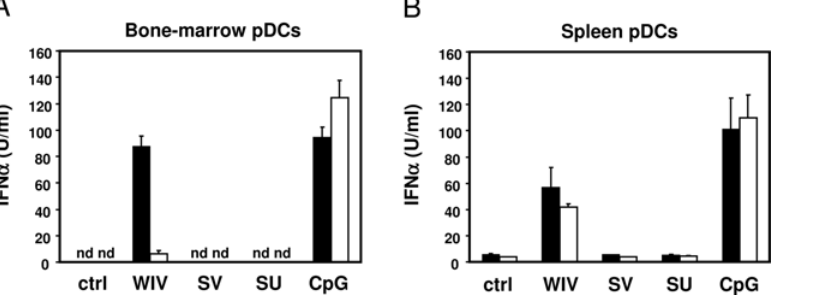
Figure 4. Induction of IFN a by WIV is TLR7-dependent in bone-marrow derived pDCs, but not in spleen-derived pDCs. Bone-marrow cells cultured with FLT3L (containing 20–30% pDCs) (A), or pDC-enriched spleen cell cultures (containing 62%–68% pDCs) (B) of wild-type mice (black bars) and TLR7 2 / 2 mice (white bars) were incubated overnight with WIV, SV, or SU vaccine. IFN a was measured in cell supernatants by sandwich ELISA. Bars represent average values of triplicate determinations with standard deviation, and are representative of three independent